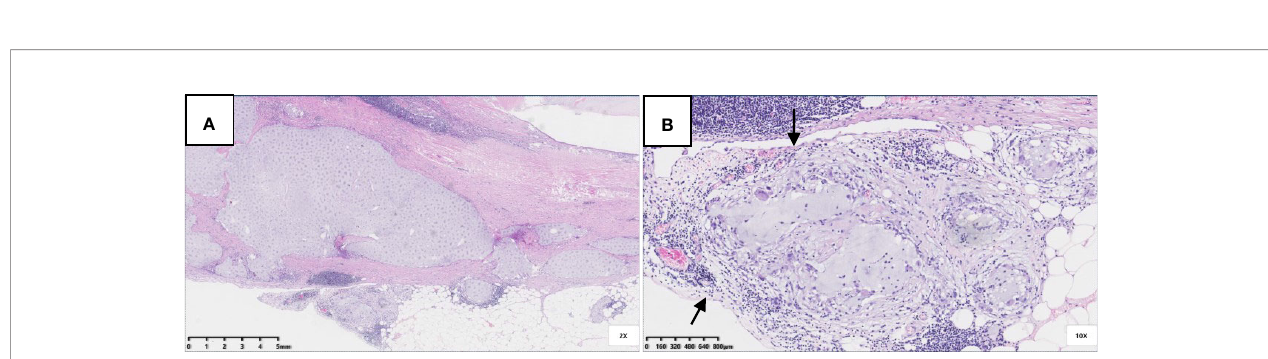
FIGURE 2 | Pathological morphology and strati fi cation of pTis. (A) pTis m : fi brosis was con fi ned to the mucosa, acellular mucinous/mucinous epithelium located in the inner side of the fi brotic mucosa (HE 100×); (B) pTis f : fi brosis extends beyond the mucosa, involving the muscularis propria, or even the whole layer, acellular mucinous/mucinous epithelium located in the inner side of the fi brotic wall (HE 100 x).